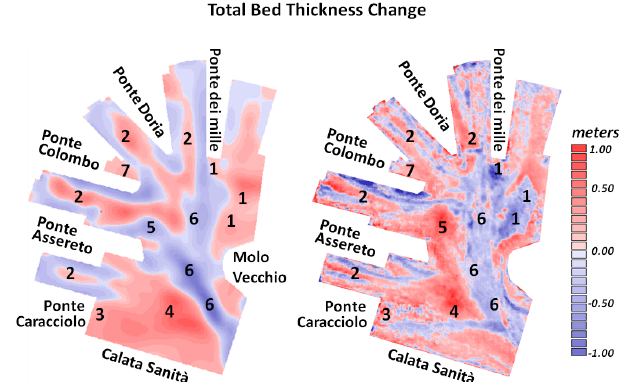
Figure 12. Annual erosion and deposition map reconstructed on the basis of the hydrodynamic and sediment transport simulations for the year